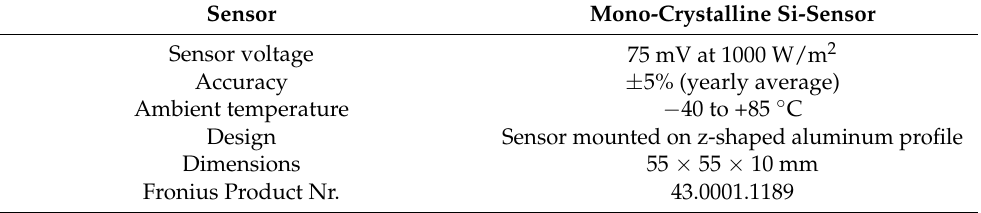
Table A3. Irradiance sensor